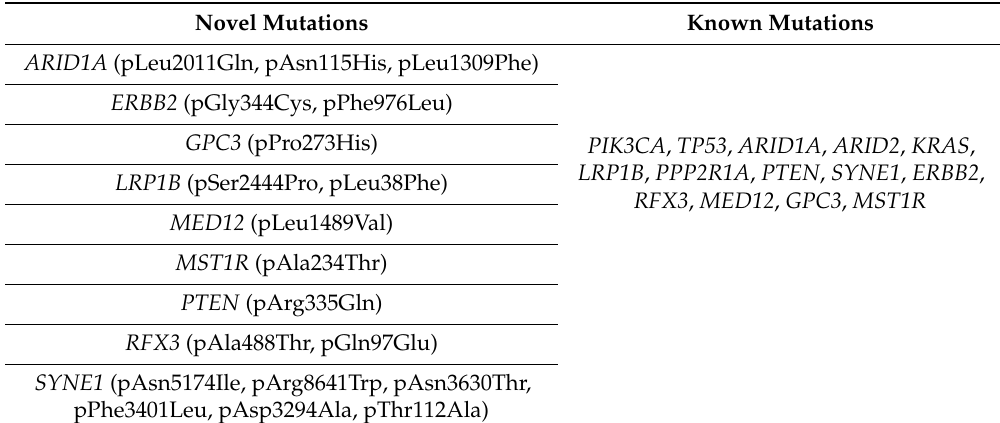
Table 1. Somatic mutations in 15 Korean OCCC